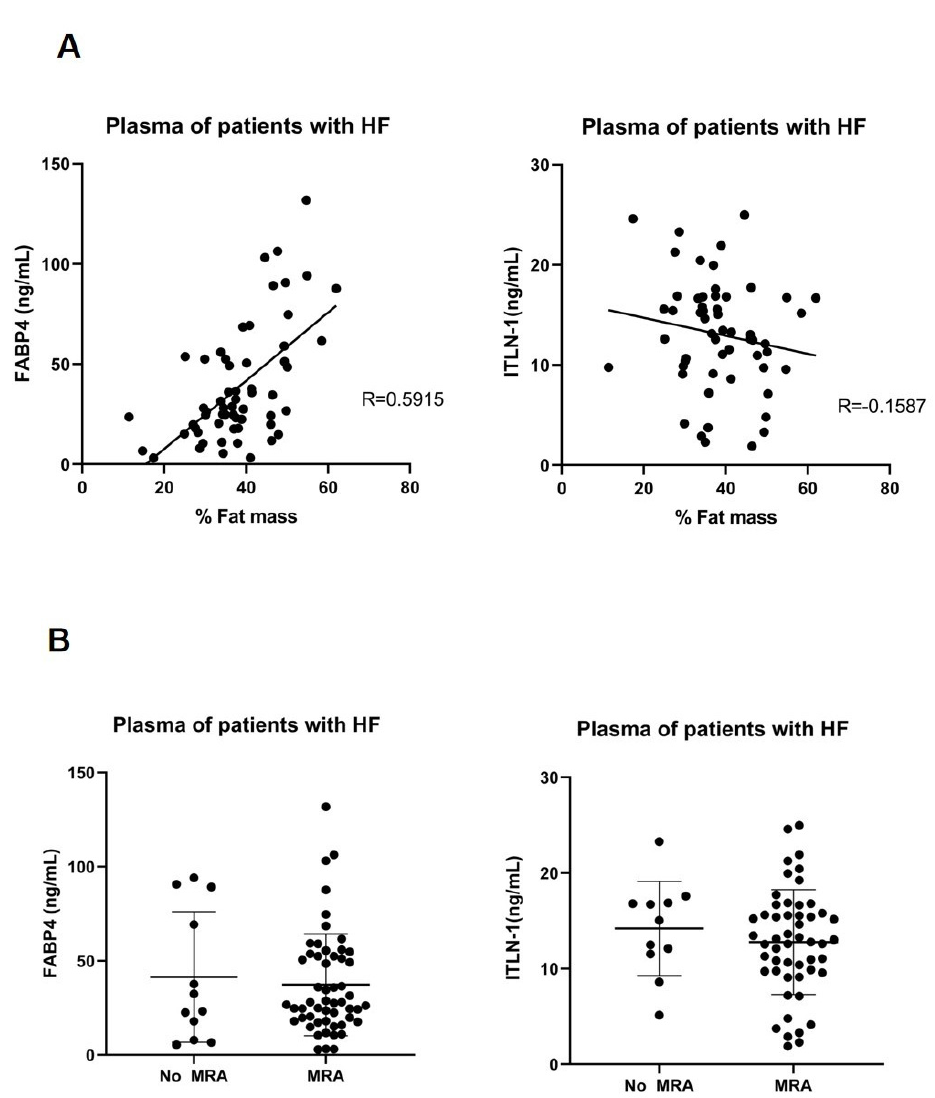
Figure 5. FABP4 and ITLN-1 plasma levels and body fat ( A ) Correlation plot represents the circulating FABP4 or ITLN-1 levels with body fat mass, measured by DEXA, in patients with HF. ( B ) FABP4 or ITLN-1 plasma levels from heart failure patients with or without mineralocorticoid receptor antagonist (MRA). Unpaired t test did not show statistical differences between groups.